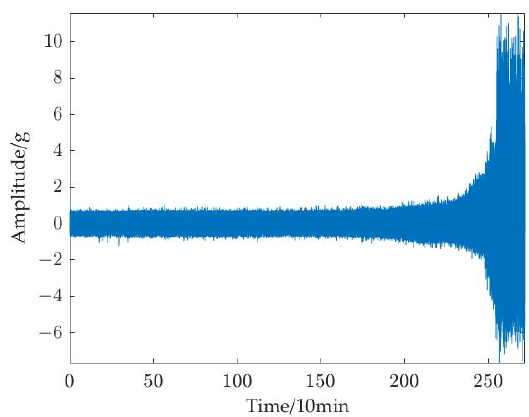
Figure 9. Time domain diagram of the rolling bearing on self-made testbed.